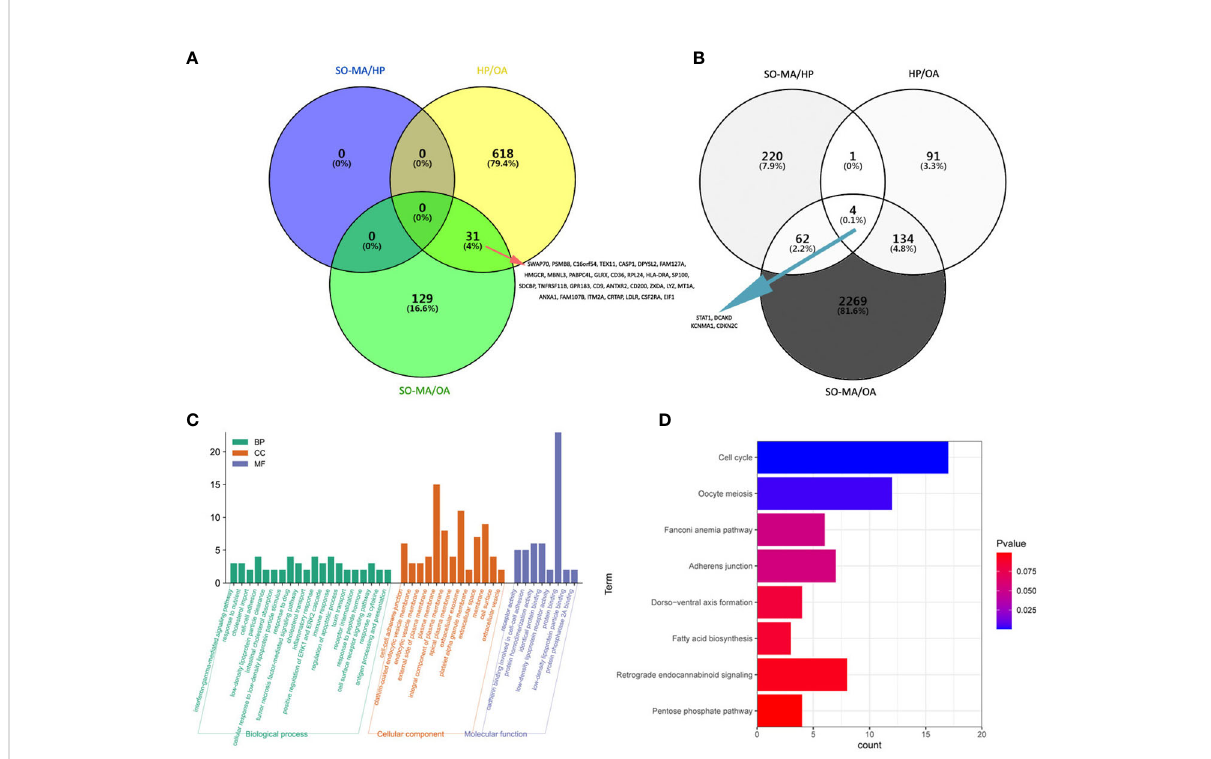
FIGURE 3 Bioinformatics analysis of differentially expressed genes and m 6 A methylation status in the three groups (the SO/MA, HP, and OA groups). (A) The Venn diagram of up-regulated mRNA gene in three groups, and the intersection area included 31 listed genes. (B) The Venn diagram of down-expressed mRNA gene in three groups, and the intersection area included four listed genes. (C) GO analysis of the 31 up-expressed and 4 down-expressed genes. (D) KEGG pathway analysis of 141 genes with signi fi cantly lower m 6 A methylation quantity both in the SO/MA and HP groups when compared to that in the OA